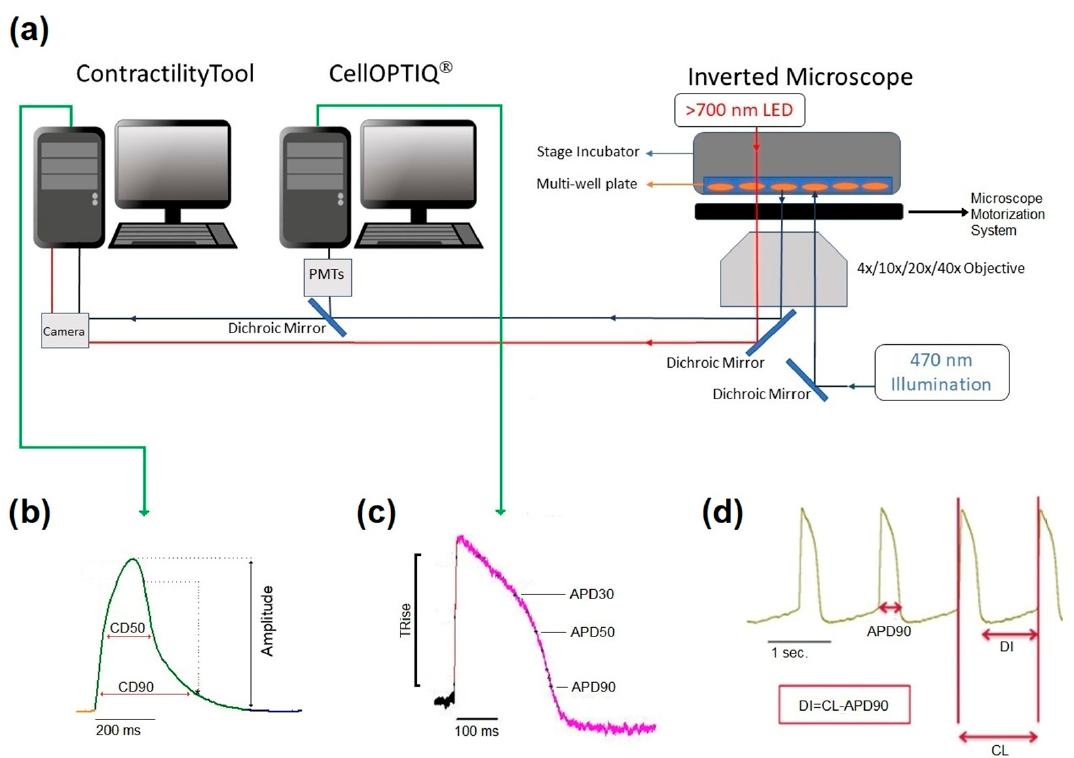
Figure 1. Diagrammatic summary of the CellOPTIQ ® /ContractilityTool ® platform ( a ). Two real-time data acquisition software systems run on separate computers. Contraction of 2D monolayer cultures of hiPSC-CMs is assessed by video recording (100 Hz 1024 × 1024) of a wide field image collected from an Olympus inverted microscope and analyzed using the MuscleMotion algorithm in real-time. Two channels of photometry-based fluorescence signals are acquired by the CellOPTIQ ® platform (10 KHz/channel), while illumination and motorized stage position are controlled by digital outputs regulated by the CellOPTIQ ® software. Cells are maintained at 37 ◦ C (5% CO 2 ) in multiwell plates using a stage incubator. Panel ( b ), example records of monolayer contraction, and corresponding action potential waveform ( c ) from hiPSC-CMs loaded with FluoVolt ® voltage-sensitive dye. ( d ) A representative train of APs and the main parameter obtained and recorded with FluoVolt ®